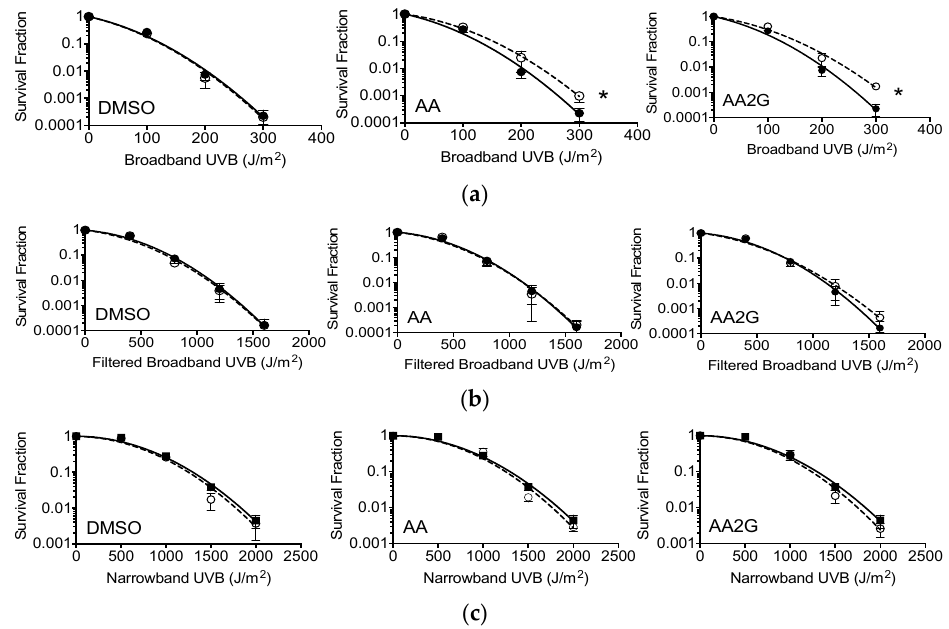
Figure 8. Cell survival curves, cells treated with DMSO, AA, AA2G before UVB light exposure: ( a ) Broadband UVB exposed CHO10B2 without plastic lids; ( b ) Broadband UVB exposed CHO10B2 with plastic lids; ( c ) Narrowband UVB exposed CHO10B2. Closed circle symbols with solid lines indicate non-drug treated control. Open circle symbols with dashed lines indicate data with chemical pre-treatment. Error bars indicate standard error of the mean. * means statistically significant differences ( F -test, p < 0.05). Table 3. D 10 values and protection ratio of UVB. Conditions D 10 of UVB (J / m 2 ) / Protection